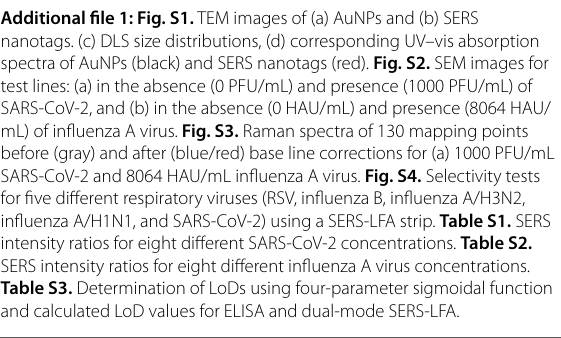
Table S3. Determination of LoDs using four-parameter sigmoidal function and calculated LoD values for ELISA and dual-mode